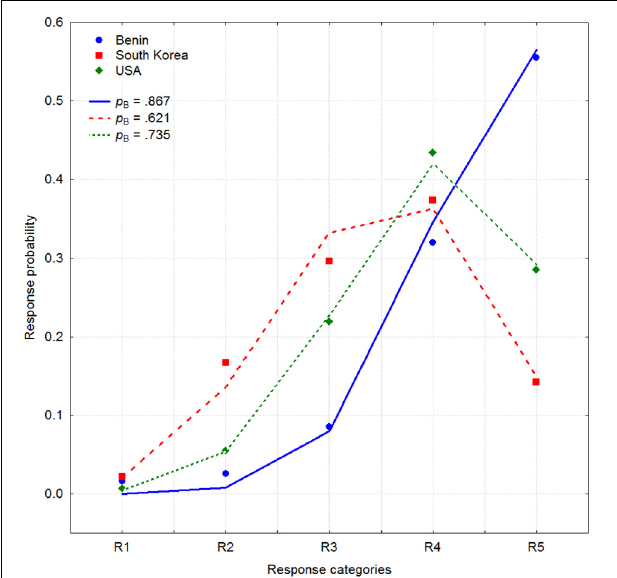
FIGURE 1 | Aggregated response frequencies on 6 Conscientiousness items for three countries: Benin (blue circles), South Korea (red squares), and the United States (green rhombus) (Mõttus et al., 2011). Three binomial distributions with values of parameter p B = 0 . 867, 0.621, and 0.735 are shown by blue, red, and green